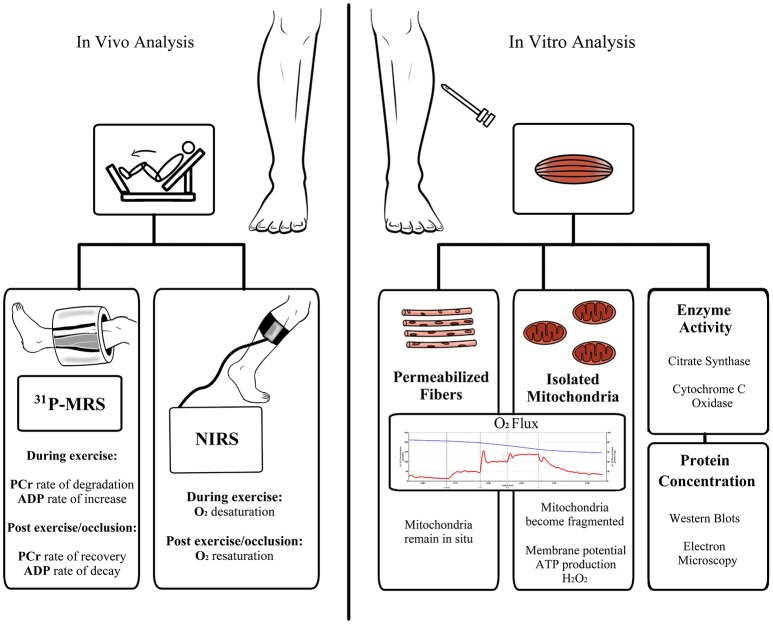
Schematic overview of available methods for the assessment of skeletal muscle mitochondrial respiratory capacity and function. Abbreviations: ADP, adenosine diphosphate; ATP, adenosine triphosphate; H2O2, hydrogen peroxide; NIRS, near-infrared spectroscopy; PCr, phosphocreatine; 31PMRS, 31Phosphorus magnetic resonance spectroscopy.